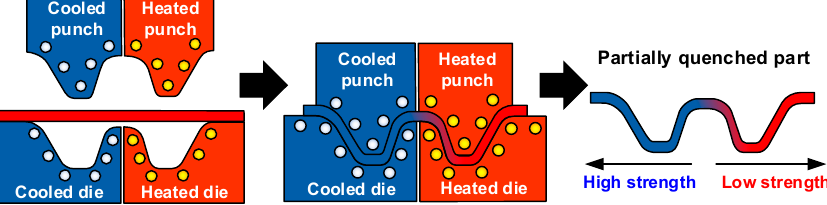
Figure 1. A schematic diagram of tailored tool thermomechanical treatment.